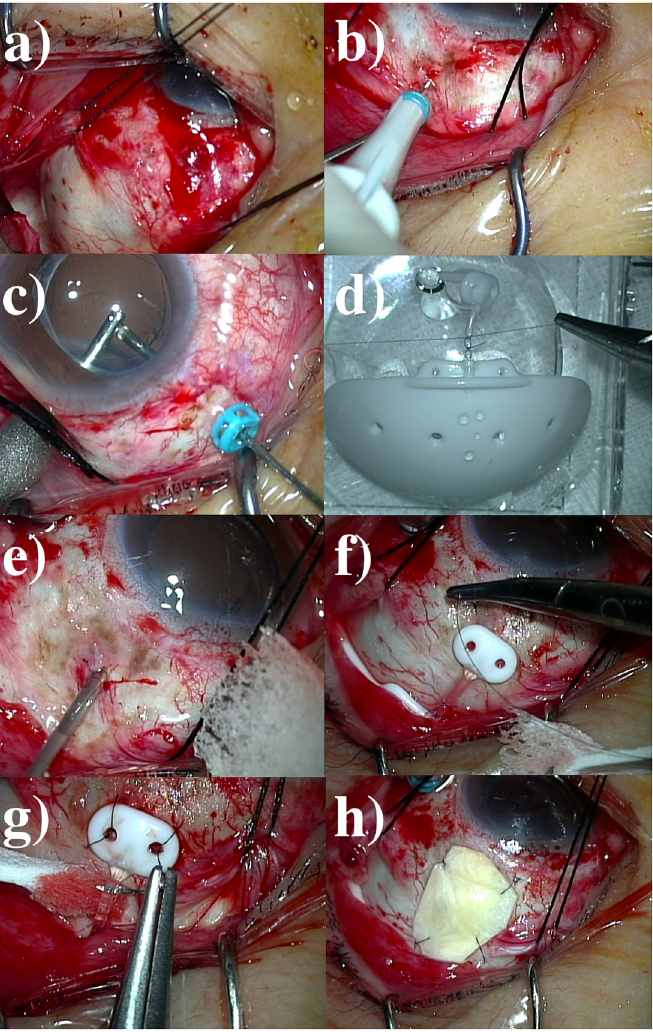
Fig 1. Intraoperative finding of Baerveldt glaucoma implant surgery in this study. a) Deployment of the surgical field with a 180˚ conjunctival incision. b) Trocar insertion in the Baerveldt implant fixation site. c) Peripheral vitreous shaving. d) Tube ligation with 8–0 Vicryl. e) A widening incision with a 20-gauge V lance. f) Fixation of the Baerveldt implant to the eyeball. g) Making a Sherwood slit. h) Patching the Hoffman elbow with a preserved